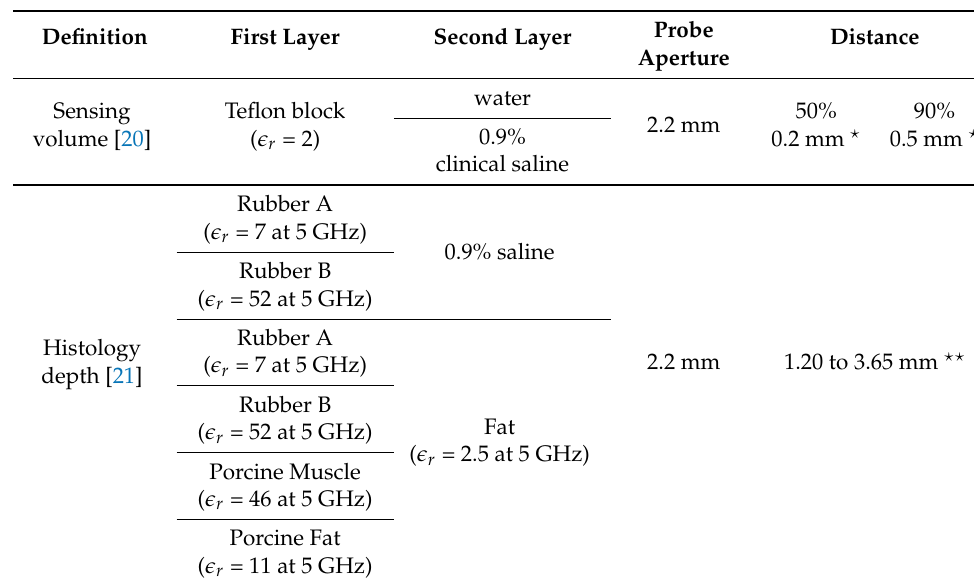
Table 3. Reported sensing depth analysis of open-ended coaxial probe with 2.2 mm aperture diameter utilizing double-layered